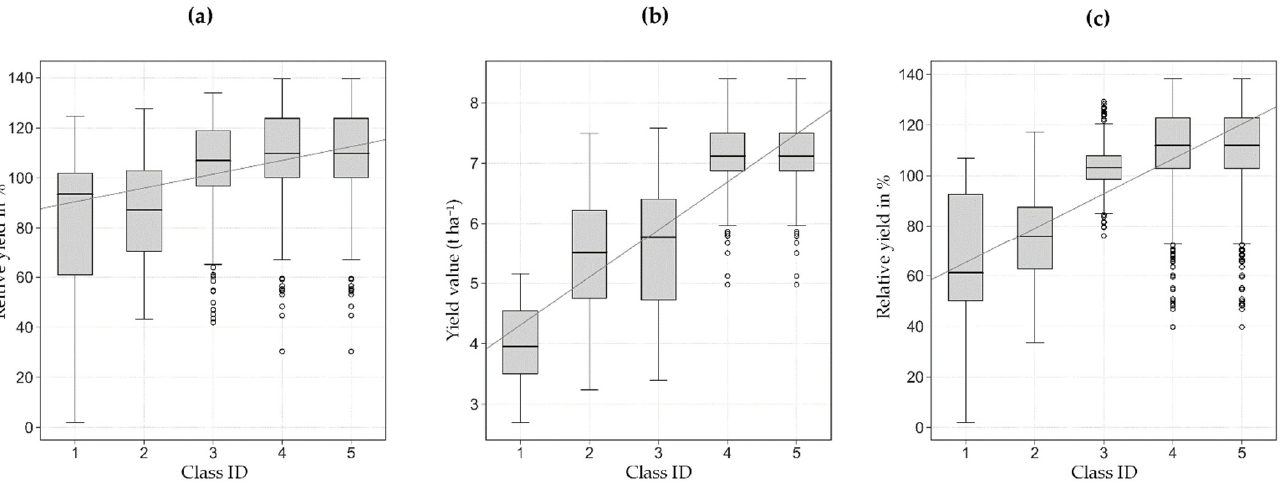
Figure 6. Boxplots of stratified sampling for model-1 ( a ), model-2 ( b ) and model-3 ( c ). The white circles out of the whiskers show outliers.